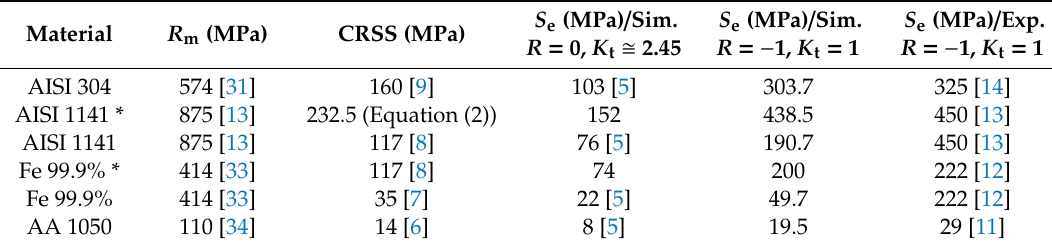
Table 3. Simulation-based S e values of the investigated materials (revised with the new results for the steel AISI 1141 and for the Fe 99.9%, marked with * in comparison with experimental values. For